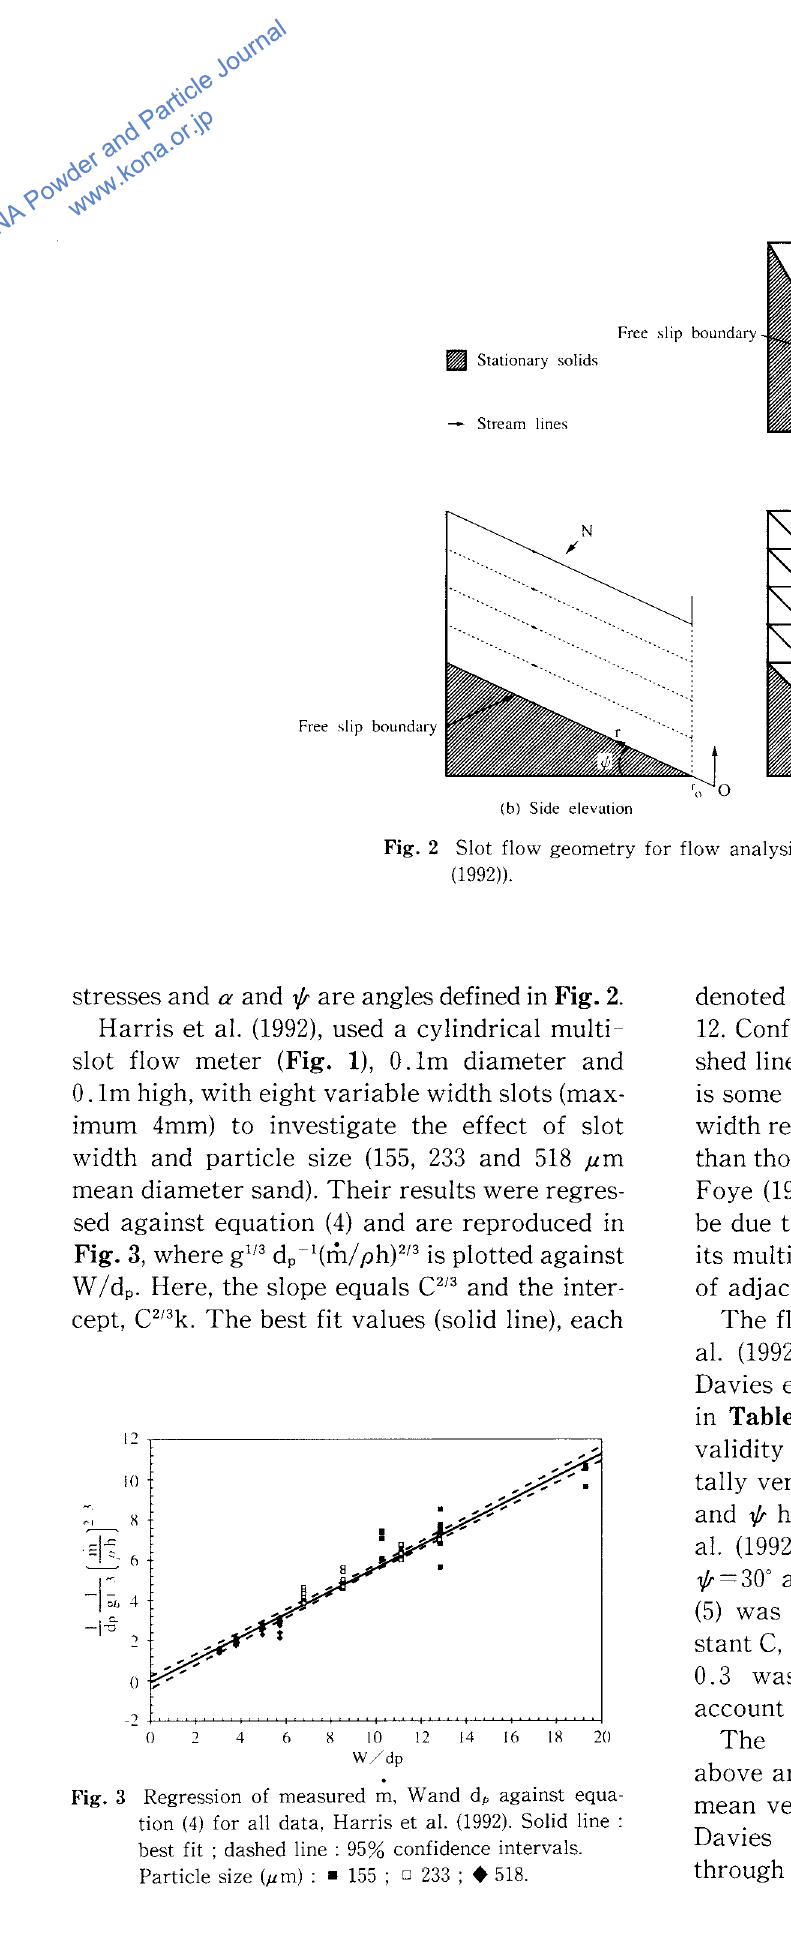
Fig. 3 Regression of measured m, Wand dp against equa tion (4) for all data, Harris et a!. (1992). Solid line : best fit ; dashed line : 95% confidence